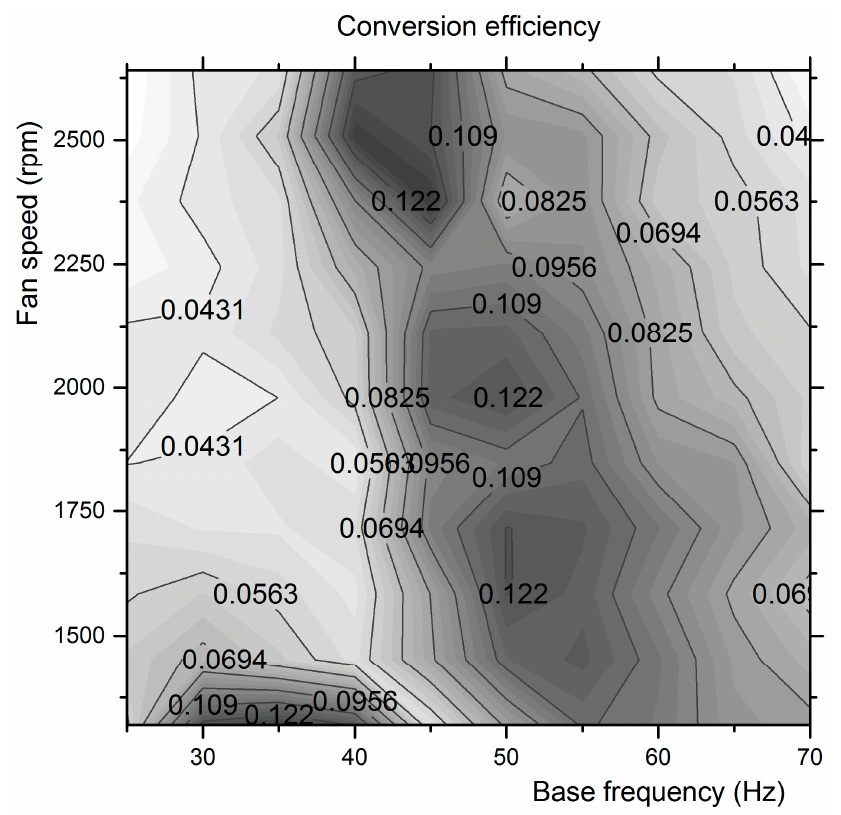
Figure 18. Mapping the energy efficiency for harvested power estimation in the combined base and aerodynamic excitation space.